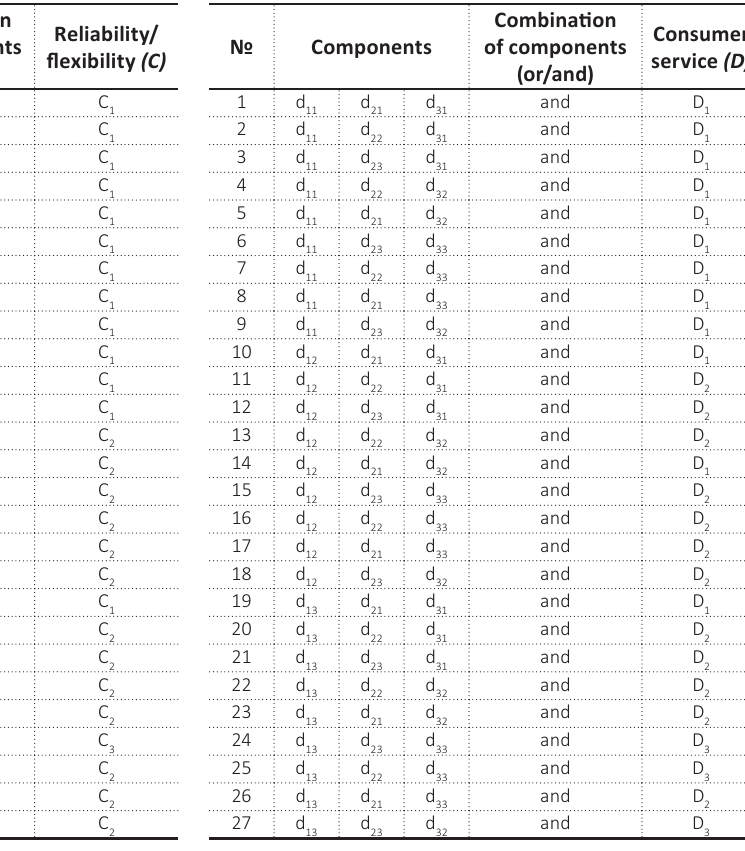
Table A7. Rules for forming reliability/flexibility assessment (C)